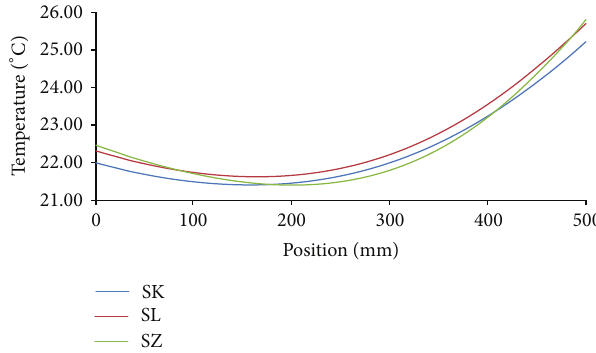
Figure13:Temperatureandmoisturecontentversustimefunctions, SK sandstone,